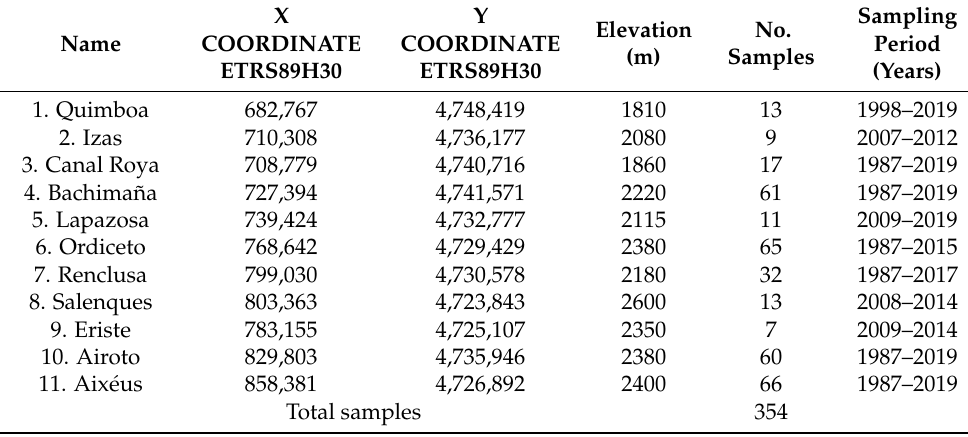
Table 1. On-site manual sampling sites. Snow poles are in the same locations as the TNM sites.